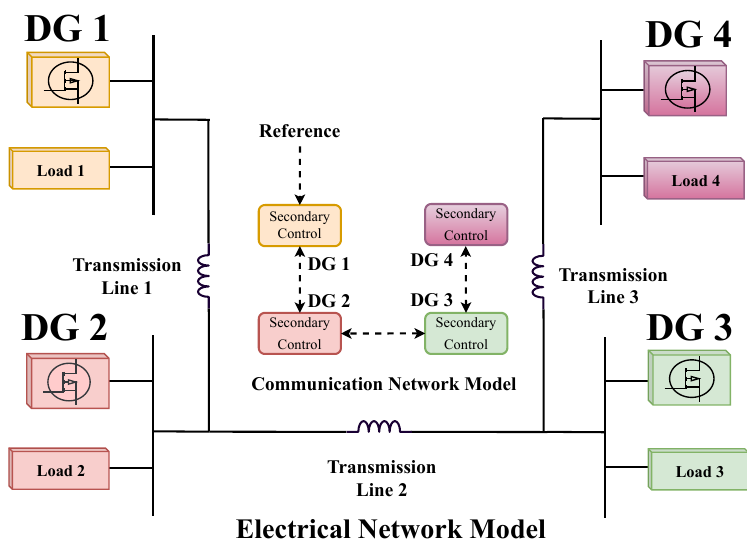
Figure 2. MG cyber-physical representation for secondary control